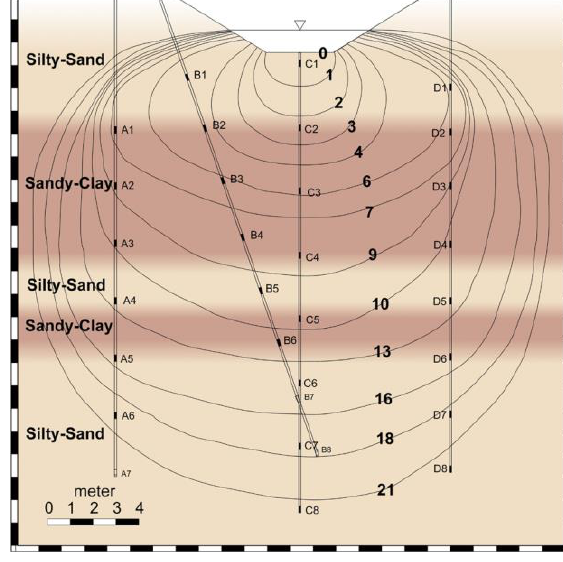
Figure 15. Immersion line change with time [29].